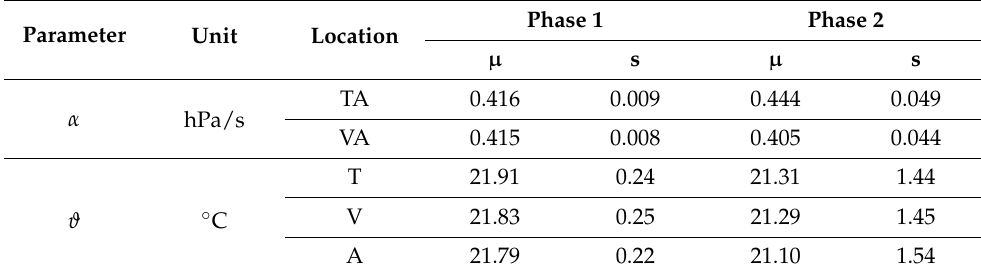
Figure A1. ( a ) Pressure changes analyzed in the test container ∝ TA (red) and vapor container ∝ VA (green) versus the air container. Gray regions represent data that were not included in the further investigation. Data corrected using Equation (12) are shown in ( b ). The solid lines (TA: black, VA: blue) represent calculated pressure changes. The orange box marked C indicates the change from Phase 1 to Phase 2. Table A3. Means (µ) and standard deviations (s) for Experiment 2.